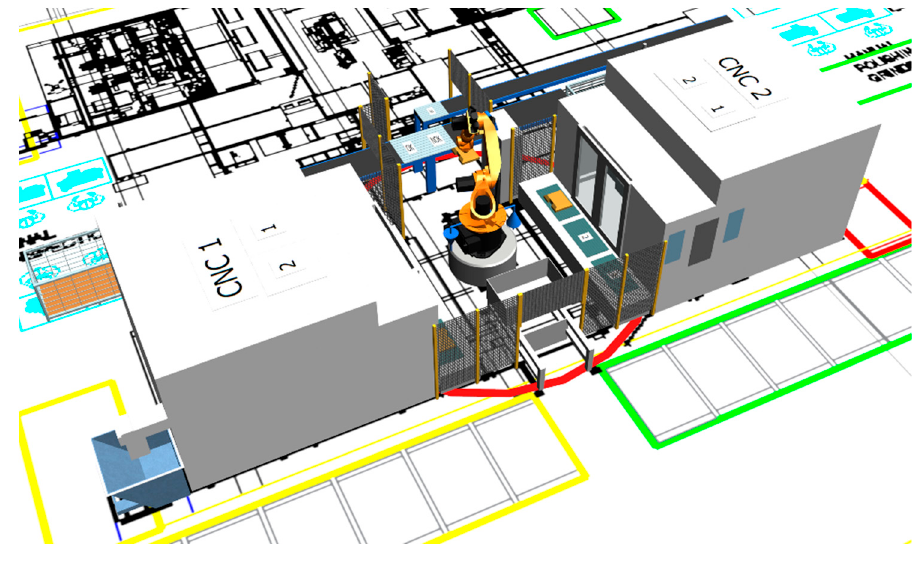
Figure 6. Machining cell visualisation in Tecnomatix Plant Simulation.